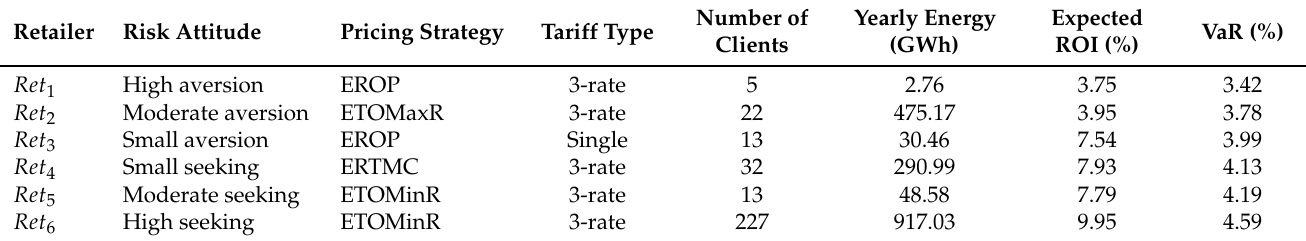
Table 1. Main characteristics of retailer agents (adapted from